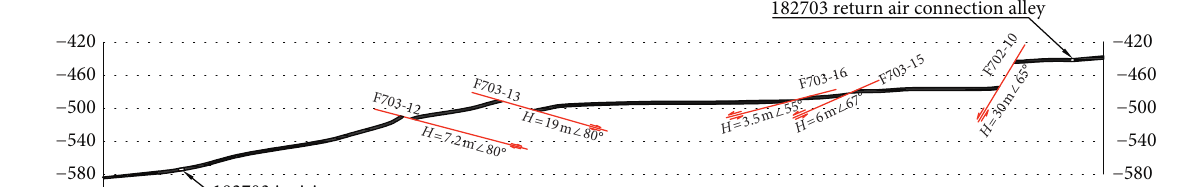
Figure 2: Fault profile in working face.